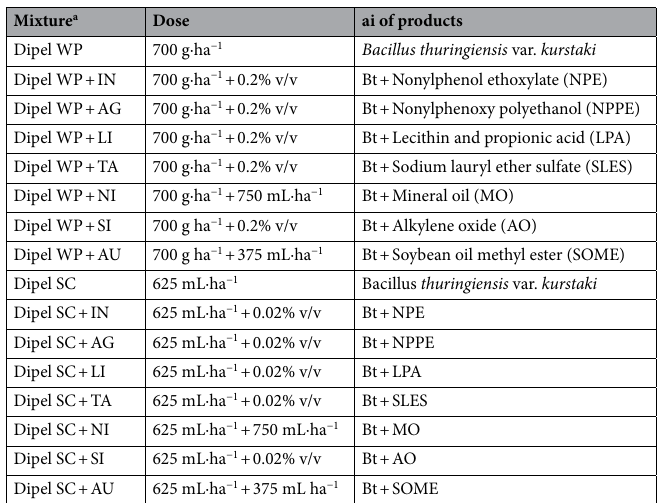
Table 3. Commercial products used to evaluate the physical and chemical characteristics of mixtures in WP and SC formulations of Dipel in terms of droplet size spectrum, contact angle, surface tension of droplets, and hydrogen and electrical conductivity. a All doses were recommended by the manufacturers for a spray volume of 150 L·ha −1 . SC suspension concentrate, WP wettable powder, AU AUREO, NI NIMBUS, IN IN-TEC, LI LI-700, TA TA35, SI SILWET, AG AGRAL, Bt Bt